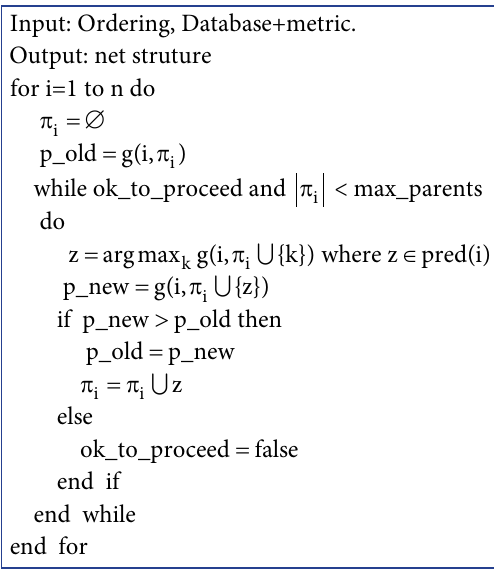
Fig. 2. Pseudo-code of the K 2 structural learning